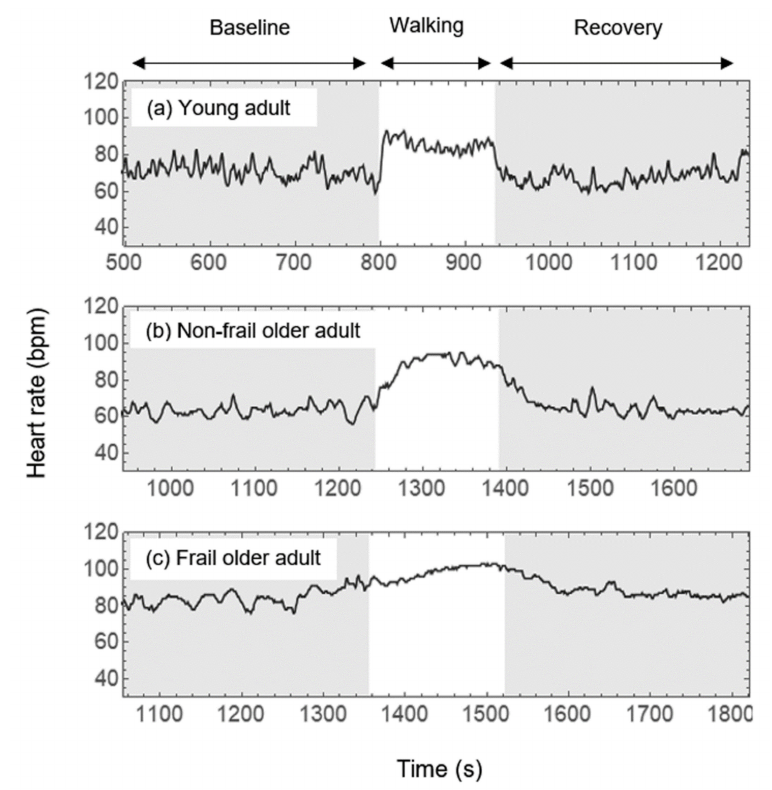
Figure 2. Heart rate time series from a selected ( a ) young adult, ( b ) a non-frail older adult and ( c ) a frail older adult during the whole test. The left fragment shaded in gray corresponds to the first 5 min of standing rest (baseline). The white part shows the fragment where participants walked a fixed distance of 160 m. Fragment sizes of walking are different as every person walked at their own preferred pace. The right gray shaded fragment corresponds with the recovery phase, which means 5 min of standing rest. Adapted with permission from Ref. [27]. 2022, AIP